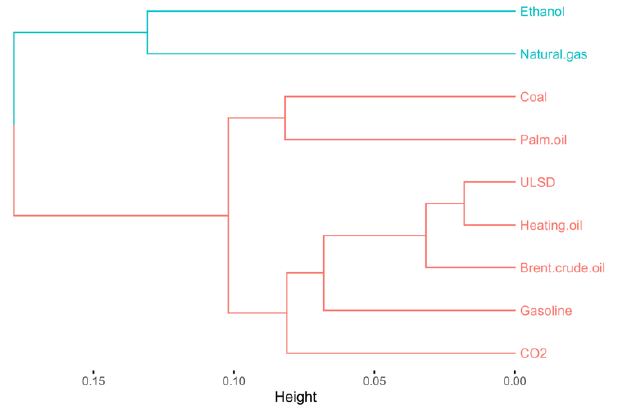
Figure 10. Dendrogram for hierarchical clustering of prices of commodities for the second subperiod.